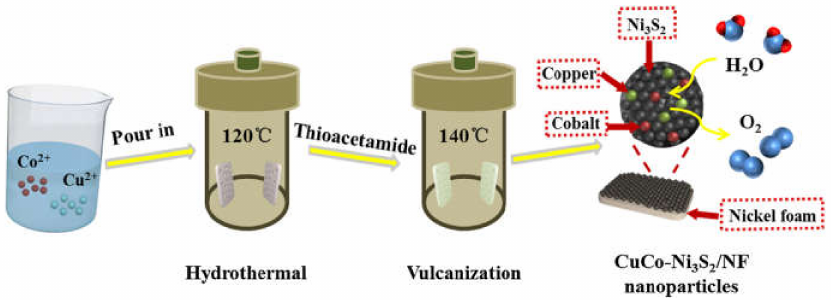
Figure 9. Fabrication processes of CuCo-Ni 3 S 2 /NF. Copyright 2020 by Elsevier